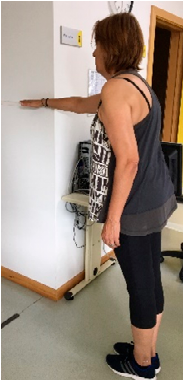
Figure 3. Functional reach test example [41].